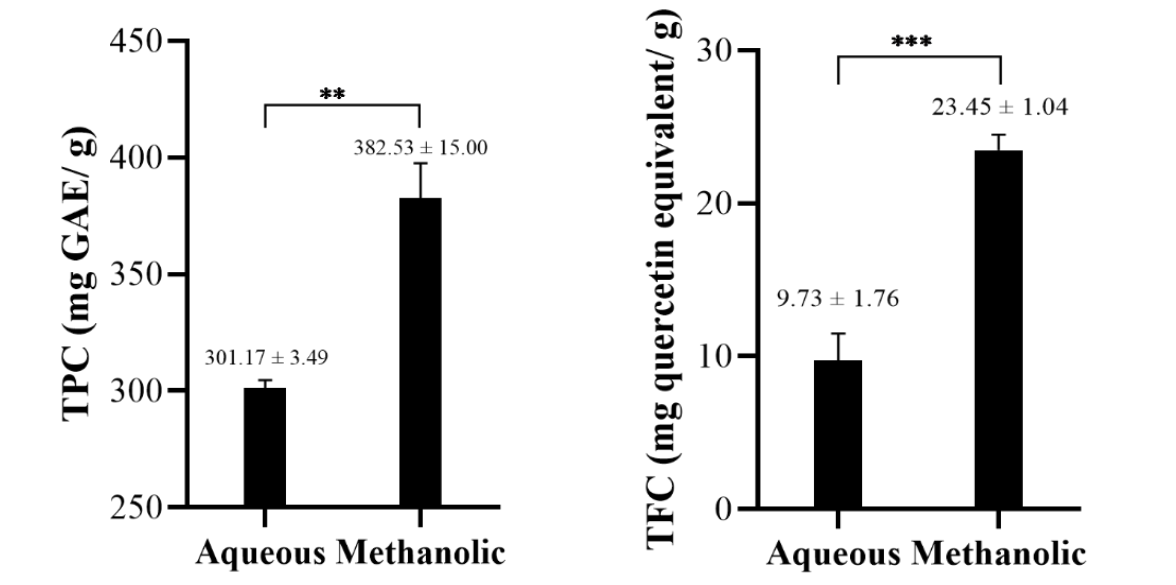
Figure 4. A comparison of TPC and TFC in 60% methanolic and aqueous extract of A. angustiloba leaves. Data show mean ± SD, n = 3. Values of ** p < 0.01, *** p < 0.001 were considered statistically different.